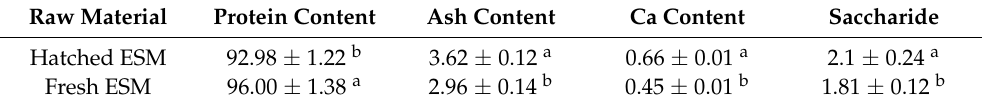
Table 1. Proximate composition of the eggshell membrane (ESM) of hatched and fresh eggs (g/100 g). Raw Material Protein Content Ash Content Ca Content Saccharide Hatched